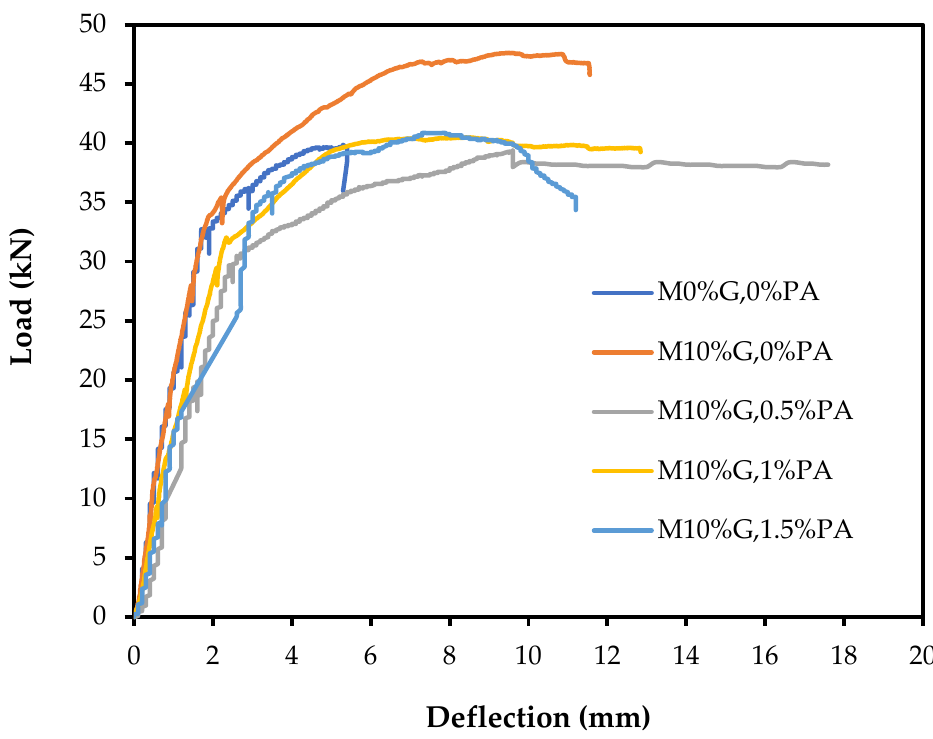
Figure 12. Load deflection for RC beams with powder glass and PA fibers. Table 4. Load deflection data for all RC beams.